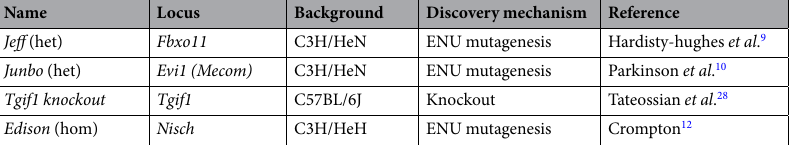
Table 1. Mouse models of chronic otitis media discovered at MRC Harwell. All develop spontaneous chronic OM within a few weeks of birth.